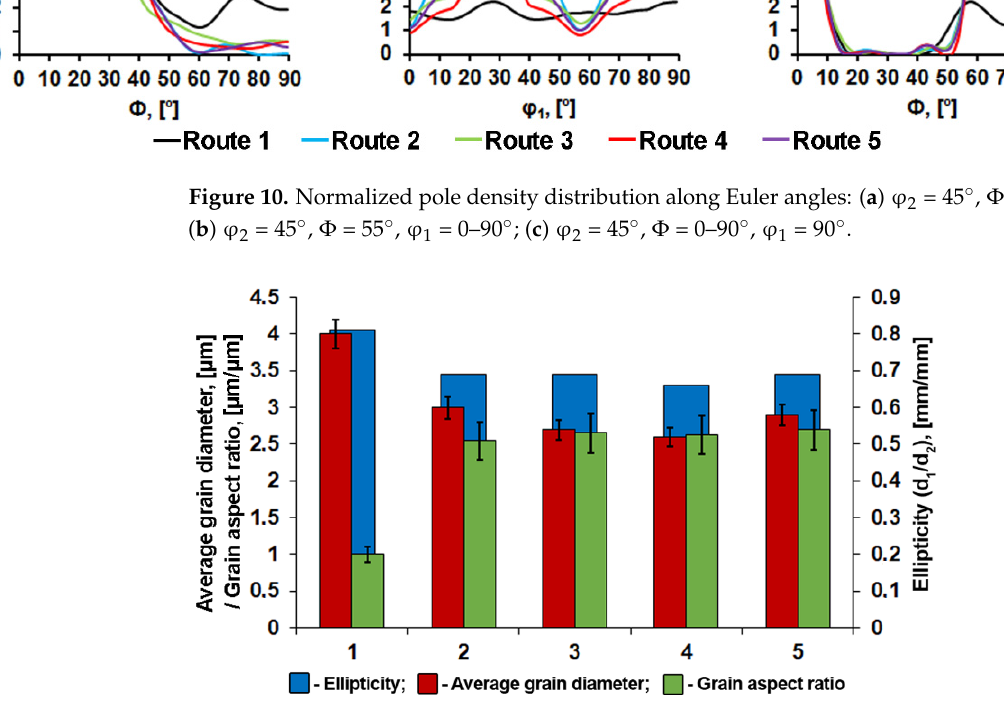
Figure 11. Dependence of tensile specimen fracture area ellipticity from crystallite shape in the cen- tral layers of pipeline steel plates. layers of pipeline steel